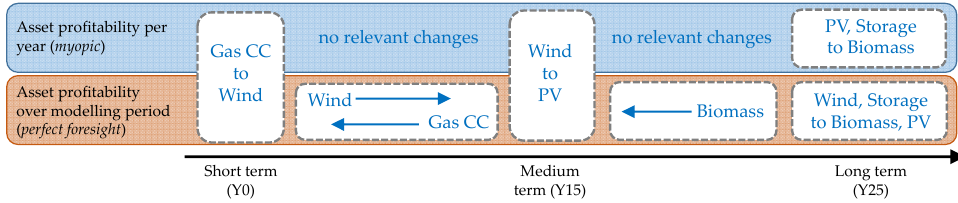
Figure 12. Investment shifts through iterative minimisation of uncovered costs in this case study.